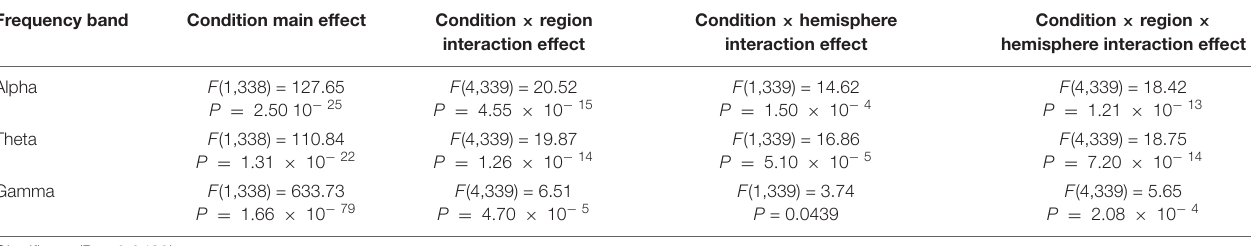
TABLE 1 | The average power variance analysis results of the two hemispheres, five regions, and two conditions in the alpha, theta, and gamma bands for anxious subjects before and after the experiment.